Question: What kind of plot is shown here?
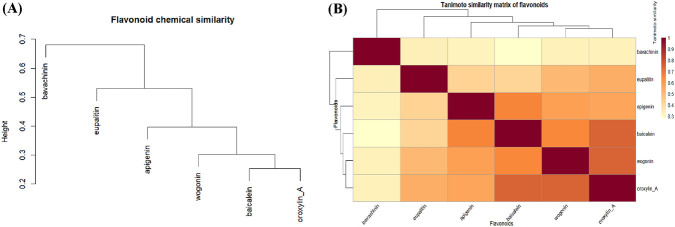
Answer: heatmap